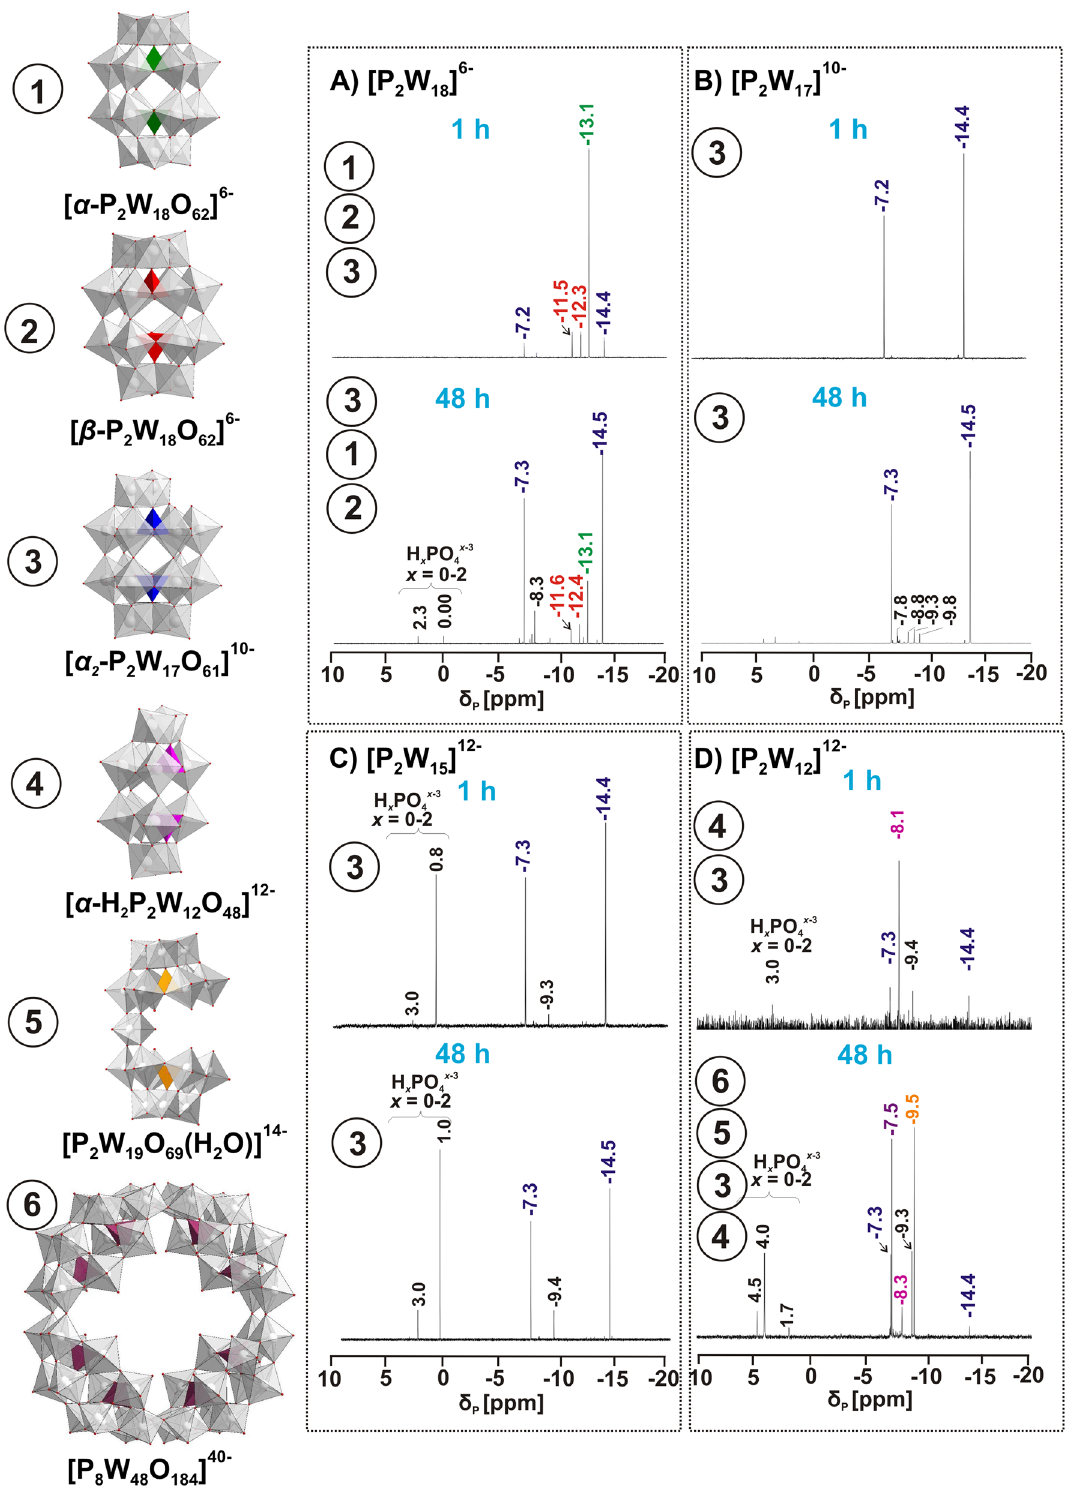
Figure 3. 31 P-NMR spectra of [ P 2 W 18 ] 6− , [ P 2 W 17 ] 10− , [ P 2 W 15 ] 12− and [ P 2 W 12 ] 12− in 50 mM Na-citrate buffer at pH 6.8 (Table S2) recorded 1 h and 48 h after preparation. A) educts: [ α -P V 2 W VI 18 O 62 ] 6− and [ β -P V 2 W VI 18 O 62 ] 6− ; products: fresh —[ α/β -P V 2 W VI 18 O 62 ] 6− (88%) and [ α 2 -P V 2 W VI 17 O 61 ] 10− (12%), after 48 h – [ α/β -P V 2 W VI 18 O 62 ] 6− (15%) and [ α 2 -P V 2 W VI 17 O 61 ] 10− (69%); B) educt [ α 2 - P